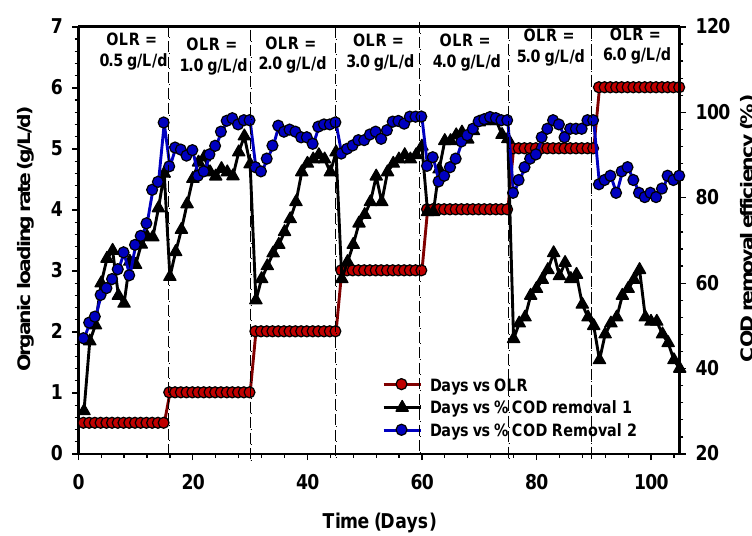
Figure 4. Variation in COD removal efficiency of UASB 1 and 2.